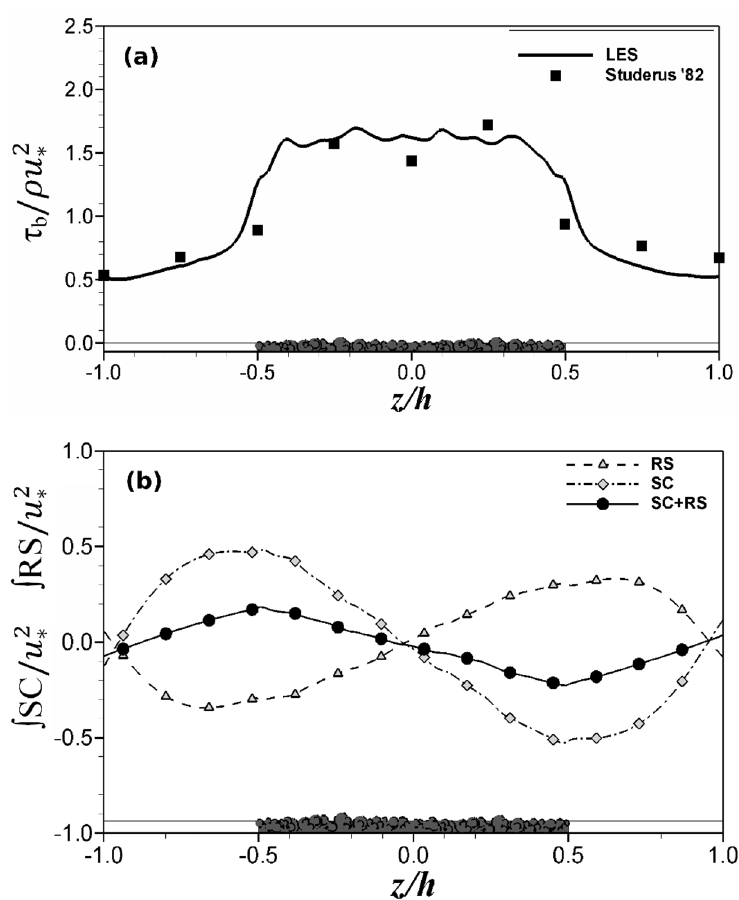
Figure 12. Spanwise distribution of bed-shear stress ( a ) and apparent shear stress ( b ) over smooth and rough